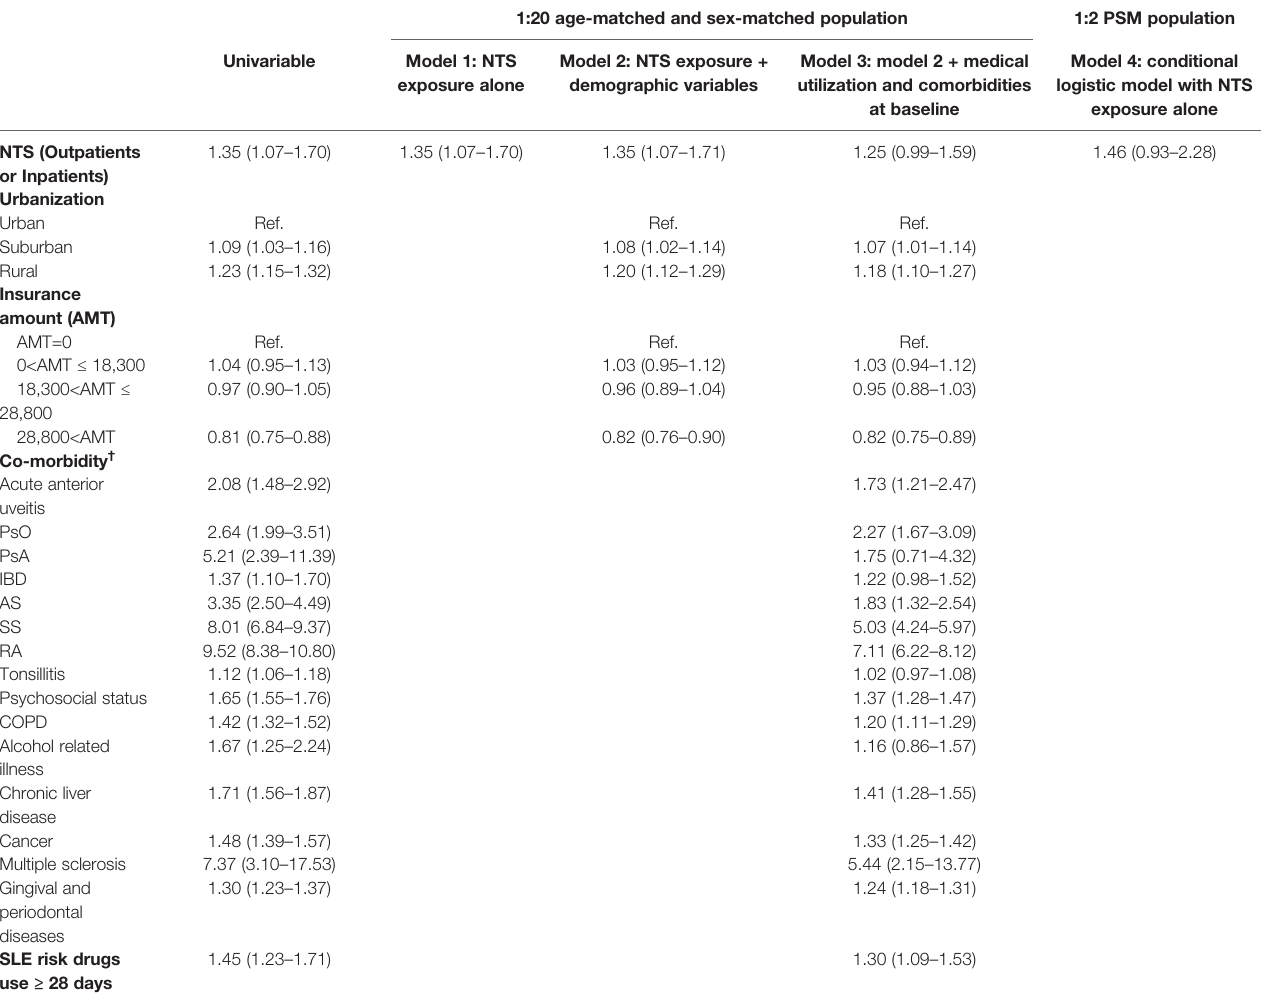
TABLE 2 | Unadjusted and adjusted odds ratios for SLE and exposure to NTS. 1:20 age-matched and sex-matched population 1:2 PSM population Univariable Model 1: NTS Model 2: NTS exposure + Model 3: model 2 + medical Model 4: conditional exposure alone demographic variables utilization and comorbidities logistic model with NTS at baseline exposure